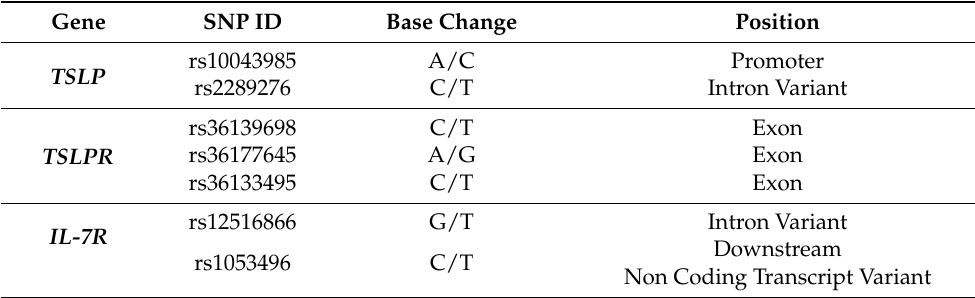
Table 2. TSLP, TSLPR, and IL-7R SNP numbers and